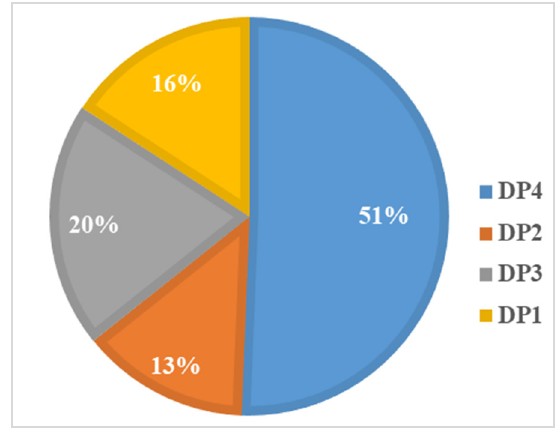
Figure 3. Factor loadings of various food items in each dietary pattern.